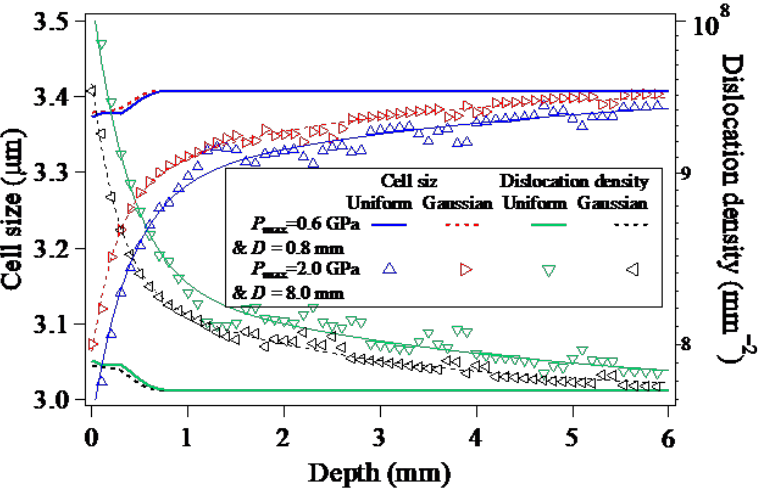
Figure 7. Evolution of the in − depth cell sizes and dislocation densities of target material during the LSP process.